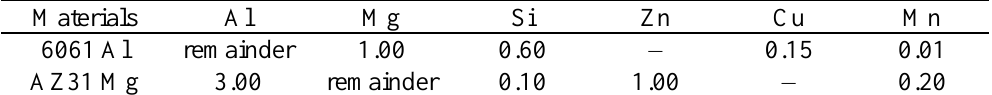
Table 1. Chemical compositions (wt%) of the 6061 Al alloy and AZ31 Mg alloy.